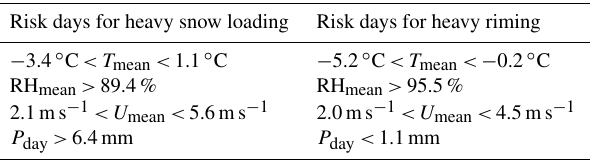
Table 2. Threshold values of daily 2m mean air temperature ( T mean ), 2m mean relative humidity (RH mean ), 10m mean wind speed ( U mean ) and total precipitation ( P day ) determined by Lehto- nen et al. (2014) for risk days favourable for heavy snow loading and heavy